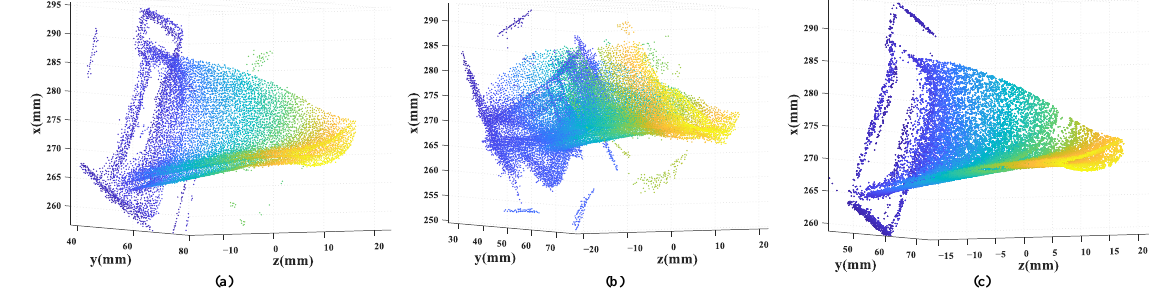
Figure 7. 3D modeling results obtained by three methods. ( a ) is the result of the incremental open- loop registering method. The object structure cannot be recovered in ( b ) because of the disadvantages of ICP. Our method performs well in ( c ).